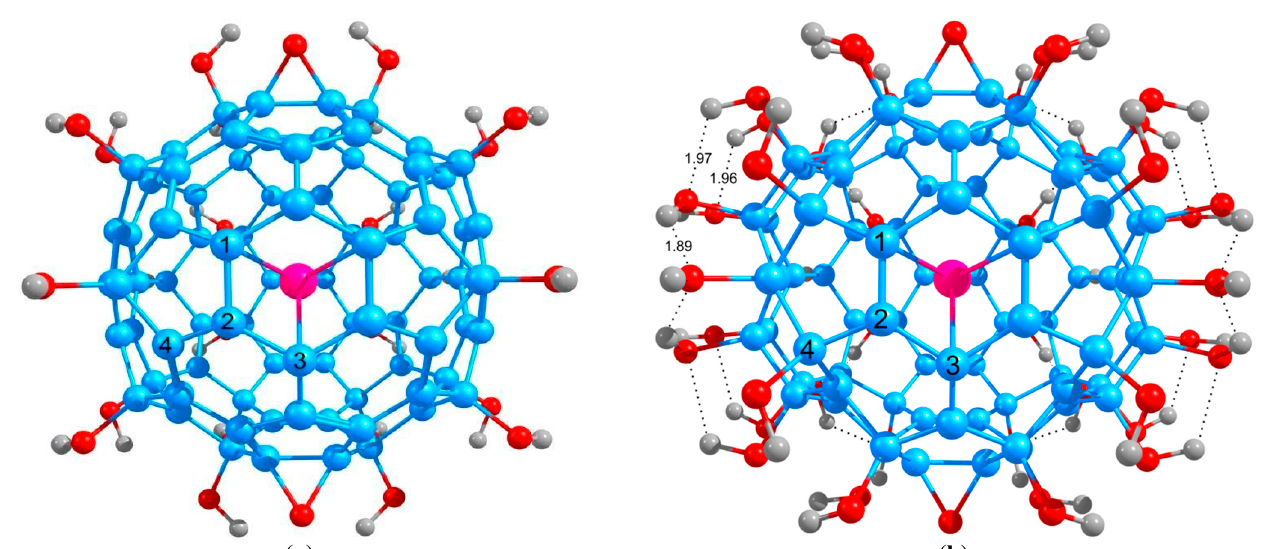
Figure 2. Atomic structure of Gd endohedral complexes of C 82 fullerenols. ( a ) Gd@C 82 O 3 (OH) 24 and ( b ) Gd@C 82 O 3 (OH) 44 . Carbon, gadolinium, oxygen, and hydrogen atoms are presented in blue, fuchsia, red, and gray colors, respectively. Carbon atoms 1 and 2 are bonded through single bond, and carbon atoms 2 and 3 are bonded through double bond. ( a ) The bond lengths l (C 1 -C 2 ) and l (C 2 =C 3 ) in Gd@C 82 O 3 (OH) 24 are 1.41 and 1.38 Å, respectively. The bond angles ∠ С 1-2-3 , ∠ С 1-2-4 , and ∠ С 3-2-4 are 120°, 109°, and 122°, respectively. ( b ) The bond lengths l (C 1 -C 2 ) and l (C 2 =C 3 ) in Gd@C 82 O 3 (OH) 44 are 1.52 and 1.33 Å, respectively. The bond angles ∠ С 1-2-3 , ∠ С 1-2-4 , and ∠ С 3-2-4 are 122°, 112°, and 121°, respectively. The dotted lines show the hydrogen bonds between hydrogen and oxygen atoms of different hydroxyl groups with bond lengths from 1.89 to 1.97 Å.